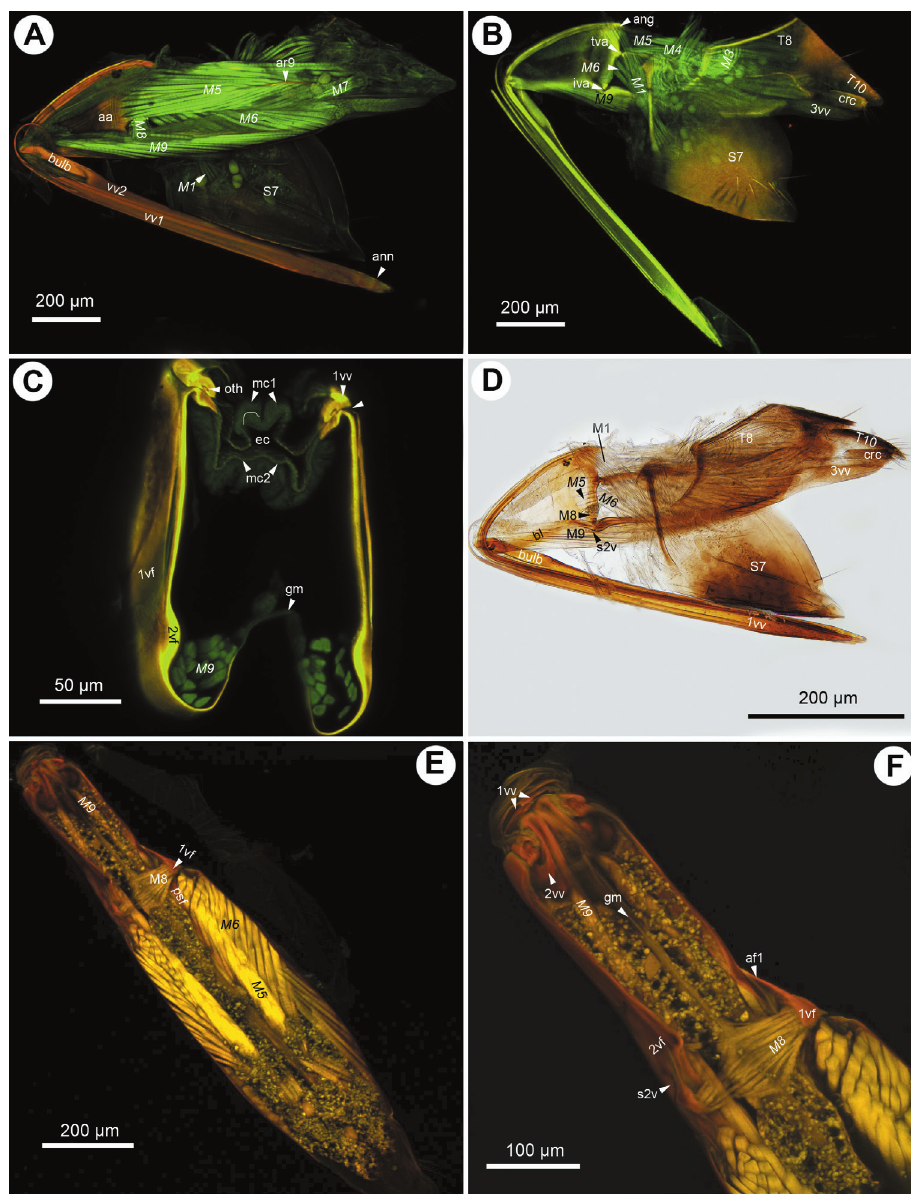
Figure 1. CLSM micrographs and bright field image showing the female terminalia of Megaspilus armatus (Say). A CLSM, medial view (doi: 10.6084/m9.figshare.156434) B CLSM, lateral view (doi: 10.6084/ m9.figshare.156442) C CLSM, transverse section, white line indicates site of separation of median con- junctivae of the first valvulae (doi: 10.6084/m9.figshare.156437) D bright field, lateral view e–F CLSM, frontal section, dorsal view (doi: 10.6084/m9.figshare.156458; doi: 10.6084/m9.figshare.156457, doi: 10.6084/m9.figshare.156456, doi: 10.6084/m9.figshare.156455). All anterior to the